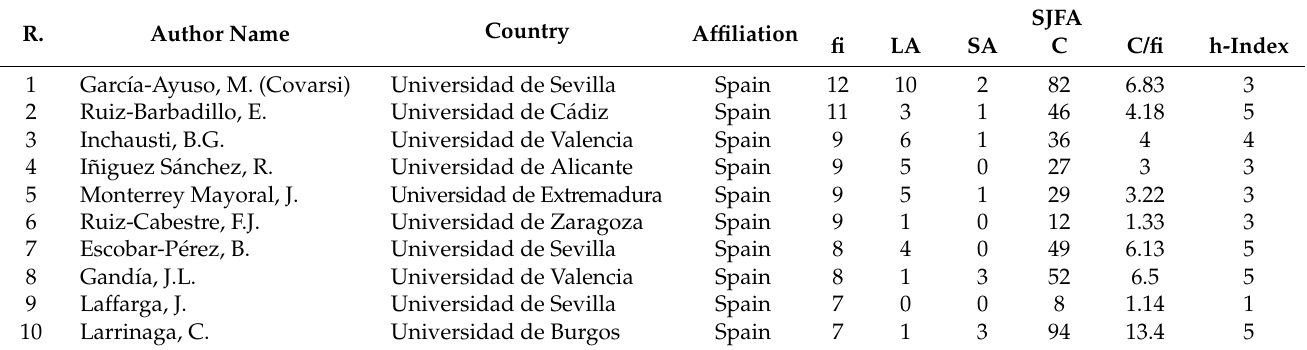
Table 6. Ranking of the most productive authors in